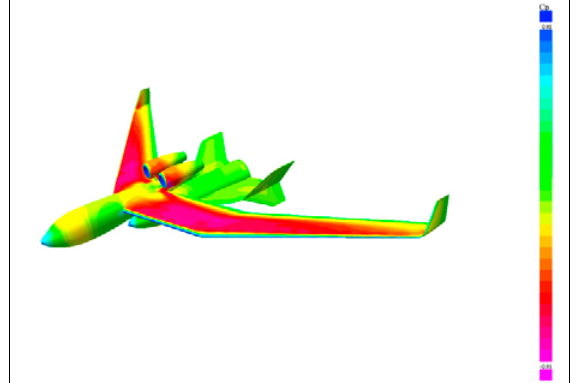
Fig. 6. The distribution of the pressure coefficient computed by MGAERO when Ma = 0.5 and AoA = 0